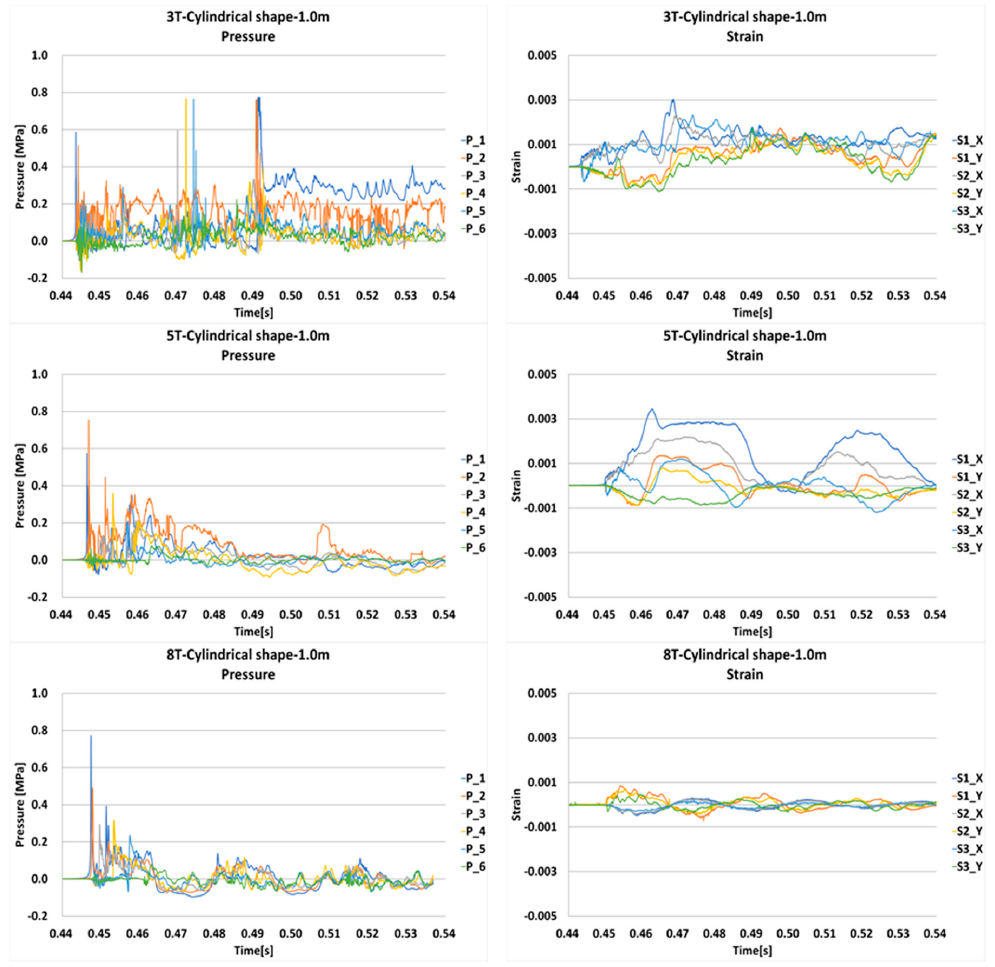
Figure 11. History of pressure and strain in the model with cylindrical shape (Drop height: 1.0 m).